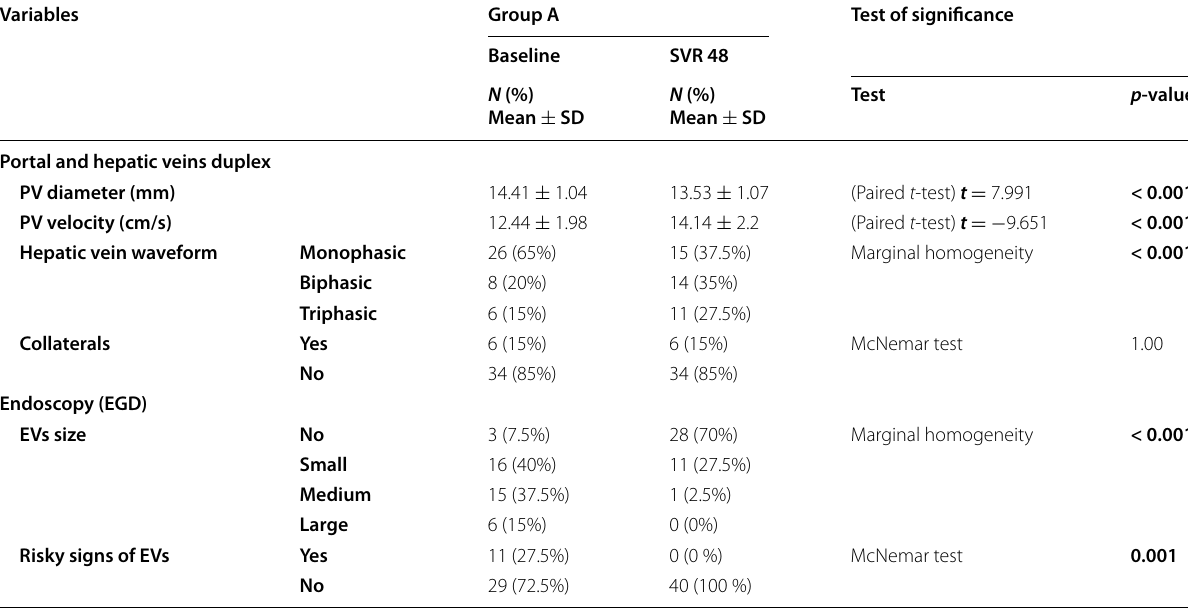
Table 4 Pairwise comparison between baseline and SVR 48 at group A regarding portal and hepatic vein duplex and EGD Variables Group